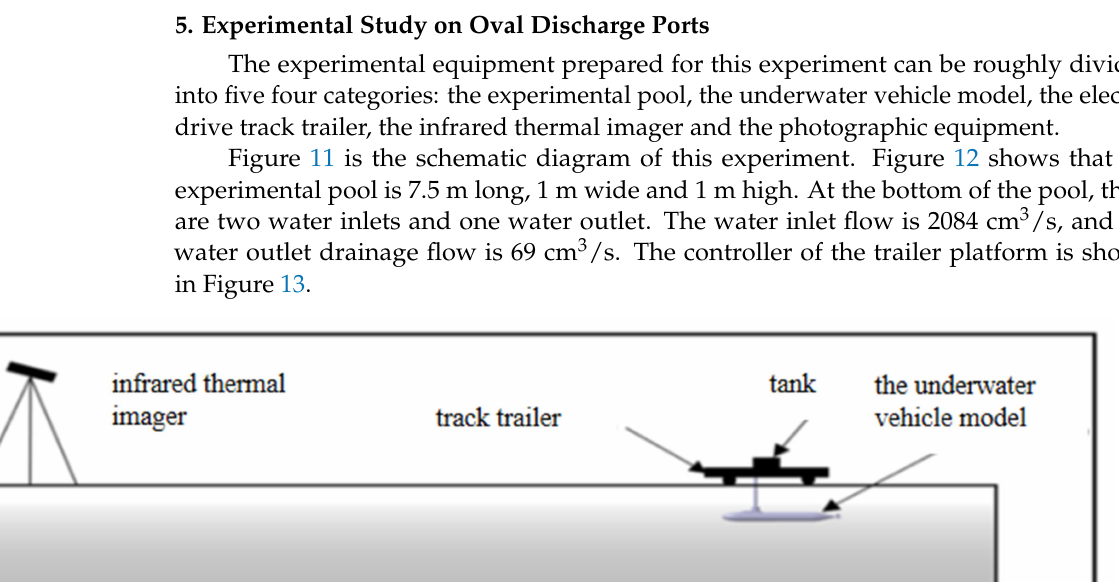
Figure 10. Flow streamline of the thermal jet for Str 1–7 discharge ports.